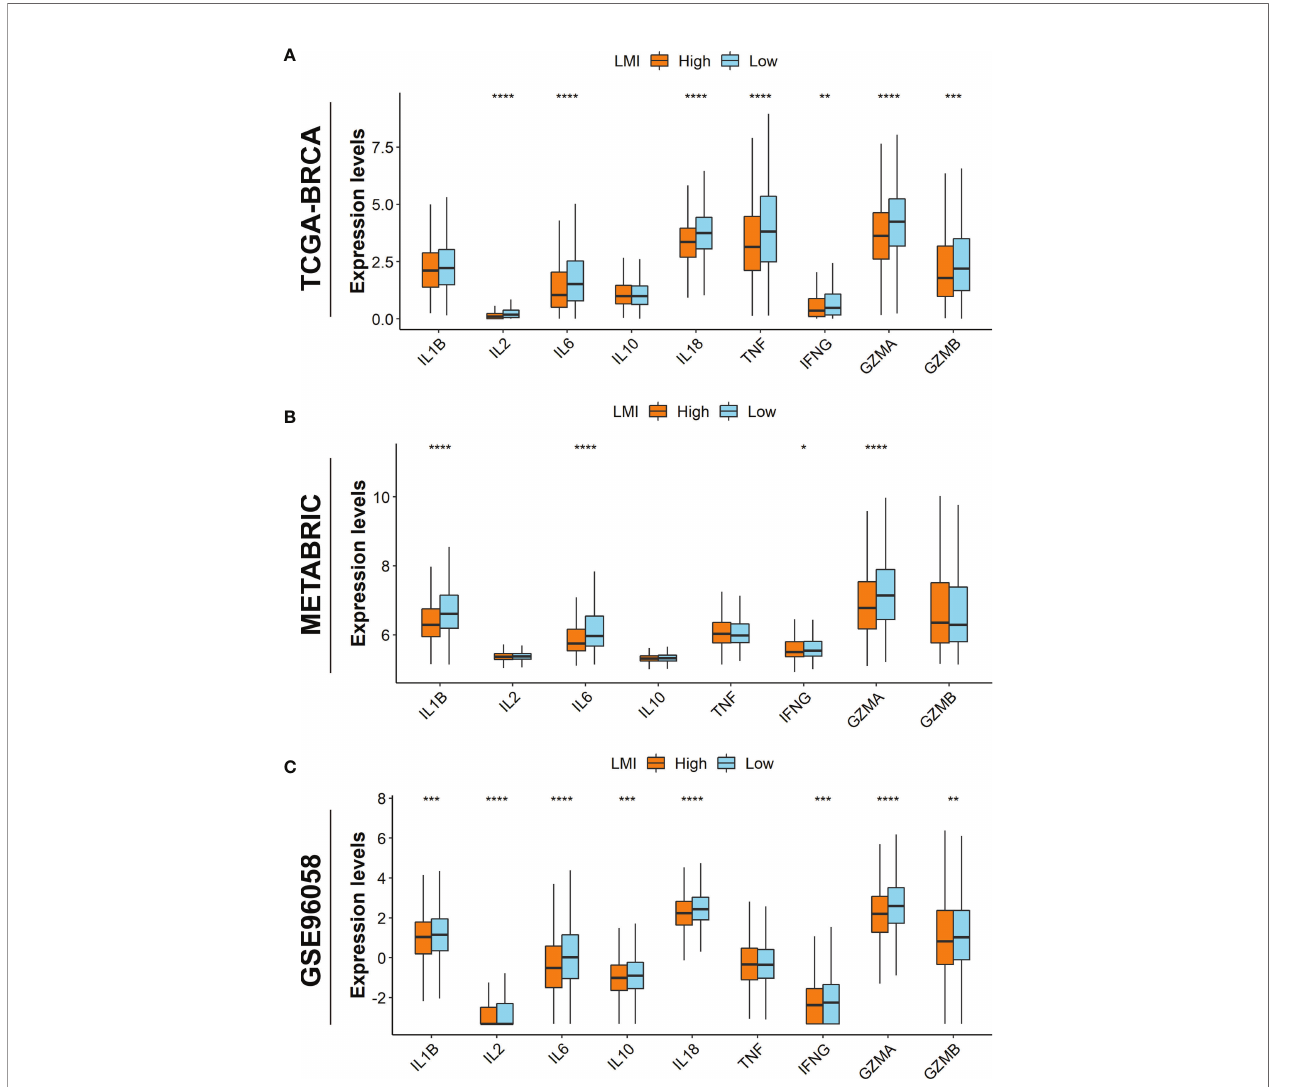
FIGURE 7 | Investigations of TME cytokines. Expression levels of IL-1B, IL-2, IL-6, IL-10, IL-18, TNF, IFNG, GZMA, and GZMB in TCGA-BRCA (A) , METABRIC (B) , and GSE96058 (C) datasets. *p < 0.05; **p < 0.01; ***p < 0.001; ****p <